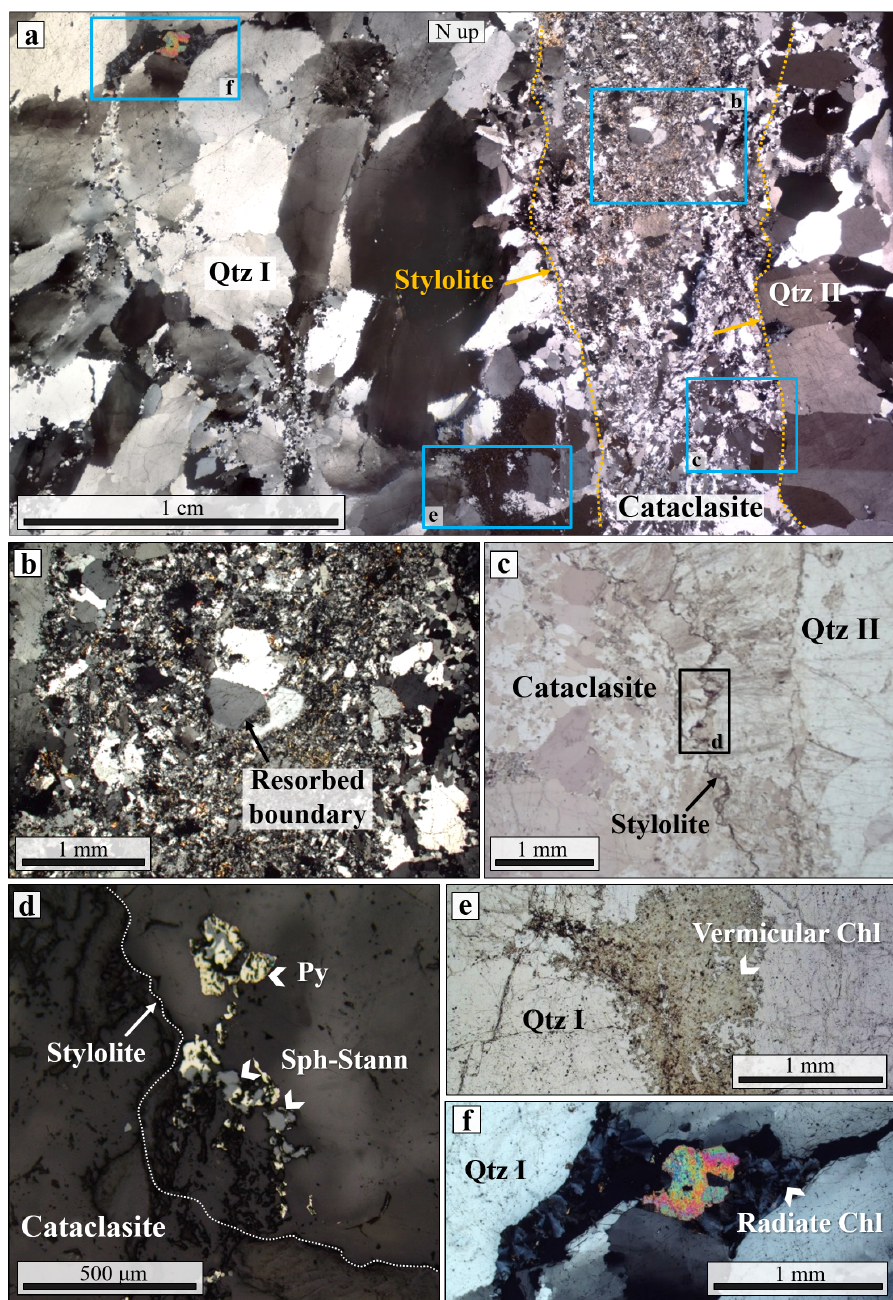
Figure 8. Microstructures of the cataclasite juxtaposing Qtz I and Qtz II veins (sample TPH-120-4). (a) Stitched photomicrographs covering the contact between the two quartz veins and the intervening 5mm thick cataclastic band. (b) Cataclastic band containing large Qtz I frag- ments (8–12mm) embedded within a finer matrix (20–200µm in size) of sericite and recrystallized quartz. The largest crystals show lobate boundaries, suggesting dissolution and local resorption along the clast–matrix interface. (c) Stylolite seams at the boundary of the cataclasite that strike parallel to the BFZ300. (d) Reflected-light photomicrograph showing anhedral to subhedral pyrite, chalcopyrite, stannite, and sphalerite arranged along the stylolite as residual products of pressure solution. (e) Vermicular and radiate (f) chlorite aggregates associated with Qtz I close to the cataclastic